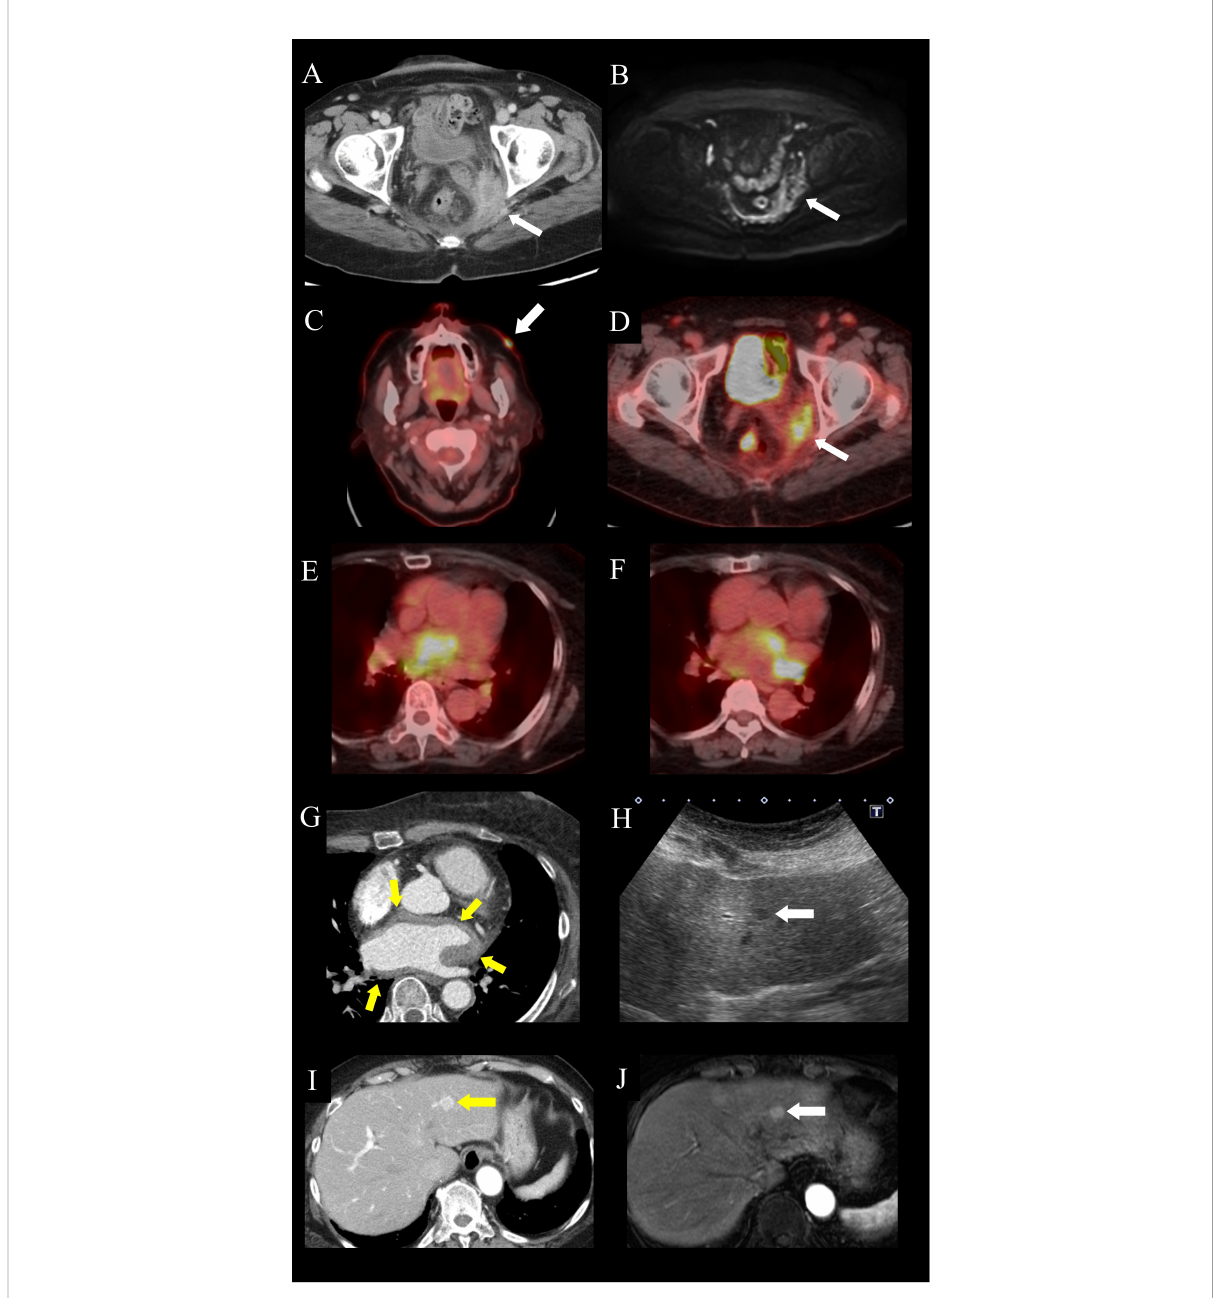
FIGURE 1 Images of extranodal lesions in the patient with Rosai-Dorfman disease. (A, B) Pelvic lesion. (A) Computed tomography (CT) scan showing an intra-pelvic mass enhanced predominantly in the peripheral zone. (B) Magnetic resonance imaging (MRI), of the intra-pelvic mass, showing heterogeneous high-intensity signals on diffusion-weighted imaging, accompanied by peritoneal thickening. (C – F) 18F- fl uorodeoxyglucose- positron emission tomography (FDG-PET)-CT of the (C) facial skin lesion (arrow), with a maximum standardized uptake value (SUVmax) of 10.7, (D) pelvic lesion (arrow), with an SUVmax of 6.2, and (E, F) peri-atrial lesion spreading from the interatrial septum to the left atrium, with an SUVmax of 25. (G) Electrocardiography-gated contrast-enhanced CT, showing homogeneous wall thickening around the left atrium (arrows). (H – J) Hepatic lesion. (H) Ultrasonography, showing a homogeneous hypoechoic nodule (arrow). (I) Contrast-enhanced CT imaging, showing a hypervascular nodule in the left lateral hepatic segment. (arrow). (J) Gadolinium ethoxybenzyl diethylenetriamine pentaacetic acid-enhanced MRI, showing a homogeneously enhanced nodule in the arterial phase